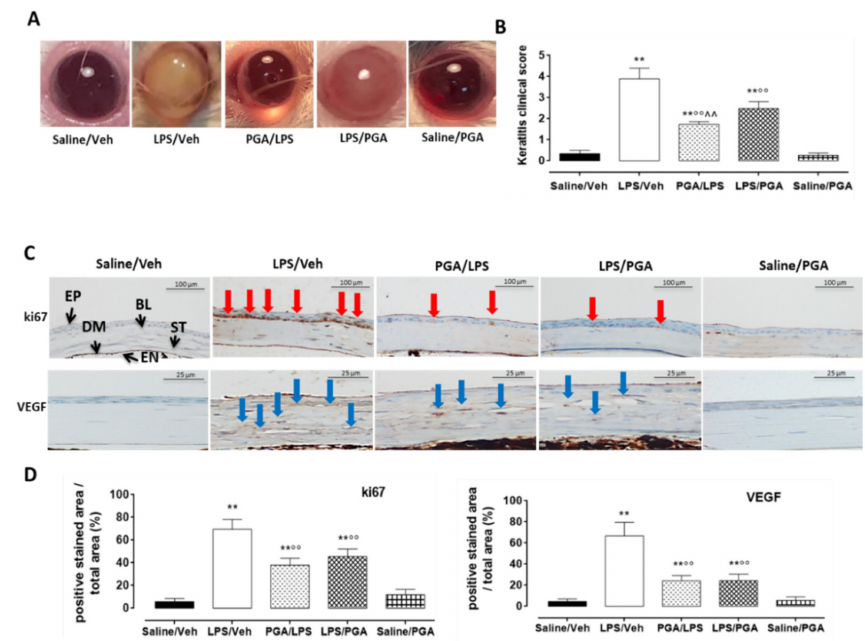
Figure 2. ( A ) Representative images of keratitis development in CD1 mice cornea. ( B ) Keratitis clinical scores. Positive keratitis was scored as > 1. Statistical significance was assessed by one-way ANOVA, followed by Tukey’s multiple comparison test of N = 5 mice/group. Saline/Veh = mice receiving intrastromal injection of 2 µ L PBS; LPS/Veh = mice receiving intrastromal injection of 2 µ g LPS dissolved in 2 µ L PBS; PGA/LPS = mice administered with PGA 5 mg/kg per os 30 min before LPS intrastromal injection; LPS/PGA = mice administered for three days with PGA 5 mg/kg per os, starting from 30 min after LPS intrastromal injection; Saline/PGA mice administered for three days with PGA 5 mg/kg per os, starting from 30 min after PBS intrastromal injection. ** p < 0.01 vs. Saline/Veh; ◦◦ p < 0.01 vs. LPS/Veh; ˆˆ p < 0.01 vs. LPS/PGA. ( C ) Representative immunohistochemical images for ki67 and VEGF corneal staining. ( D ) Ki67 and VEGF protein levels were reported as percentage (%) ± S.D. of positive stained area/total area. Statistical significance was assessed by one-way ANOVA, followed by Tukey’s multiple comparison test of N = 5 histological observations for each individual/group. EP = epithelium; BL = Bowman’s layer; ST = stroma; DM = Descemet membrane; EN = endothelium; Veh = vehicle; PBS = phosphate buffered saline; LPS = lipopolysaccharide; PGA = N -palmitoyl-D-glucosamine; red arrows = Ki67 positive stain (scale bar: 100 µ m); blue arrows = VEGF positive stain (scale bar: 25 µ m). ** p < 0.01 vs. Saline/Veh; ◦◦ p < 0.01 vs.